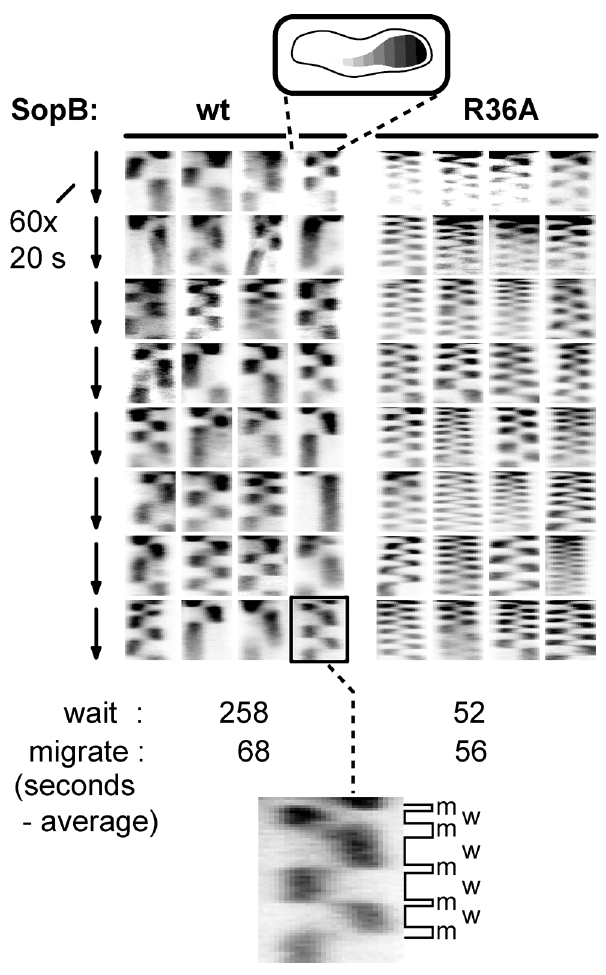
Figure 4. Effect of SopB-R36A on SopA relocation at high resolution. SopA::Xfp movement in DLT2740 ( plac-sopA::xfp )/ pDAG848 (mini-F)) cells carrying pYAS47 ( sopA + B + ) or pYAS64 ( sopA + B R36A ) grown in MGC with 1 m M IPTG was monitored as in Figure 3 but with a Nikon microscope at 20 sec intervals for 20 min using 100 msec exposure. To facilitate comparison, kymograph widths representing cell length have been equalized and brightness has been adjusted. The kymograph at bottom has been expanded to show differentiation of SopA ‘‘wait’’ (w) and ‘‘migrate’’ (m) periods; wait is defined as an exposure in which . 80% of the pixels are on one side of the mid-line, migrate as the interval between two waits.